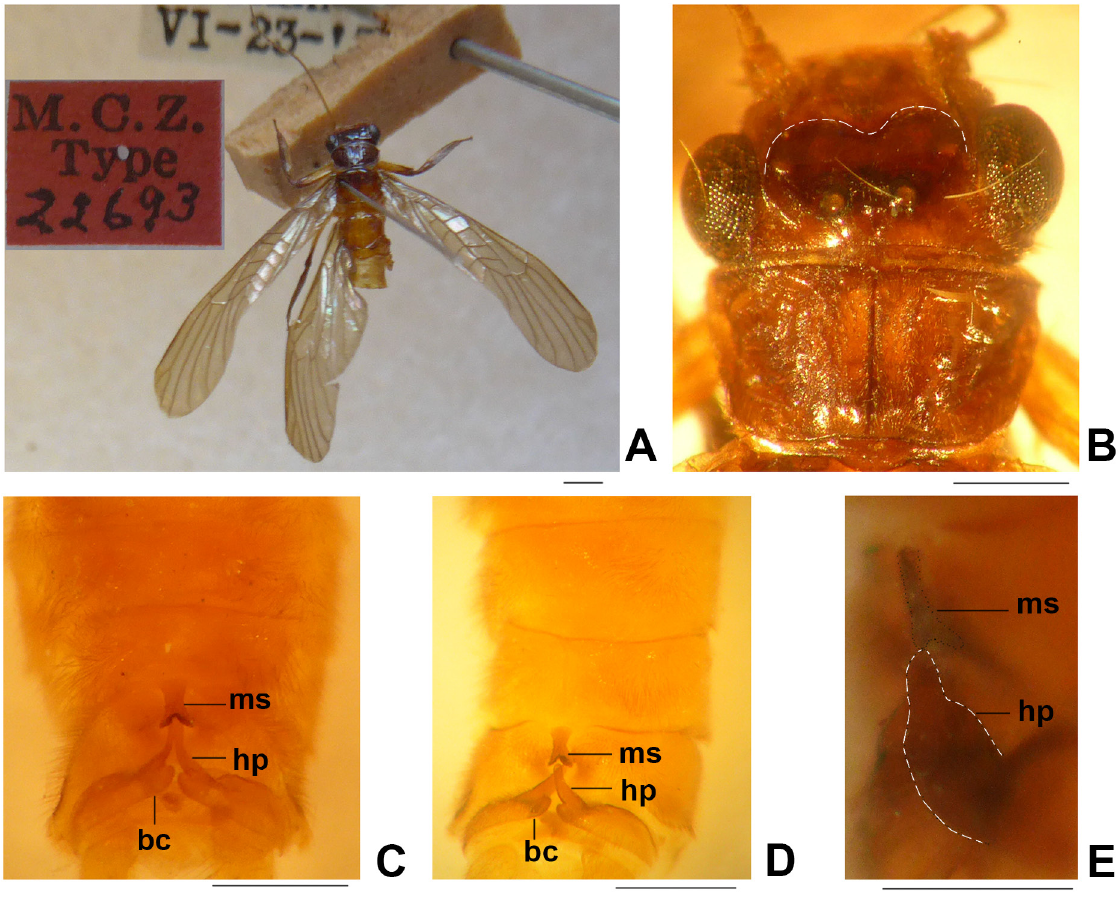
Fig . 6 . Chinoperla nigrifrons (Banks, 1939), ♂, holotype (MCZ Type 22693). A . Adult habitus, dorsal view. B . Head and pronotum, dorsal view. C . Terminalia, dorsal view. D . Cleared terminalia, dorsal view. E . Cleared terminalia, lateral view. Abbreviations: see Material and methods. Scale bars: A = 1.0 mm; B–E = 0.5